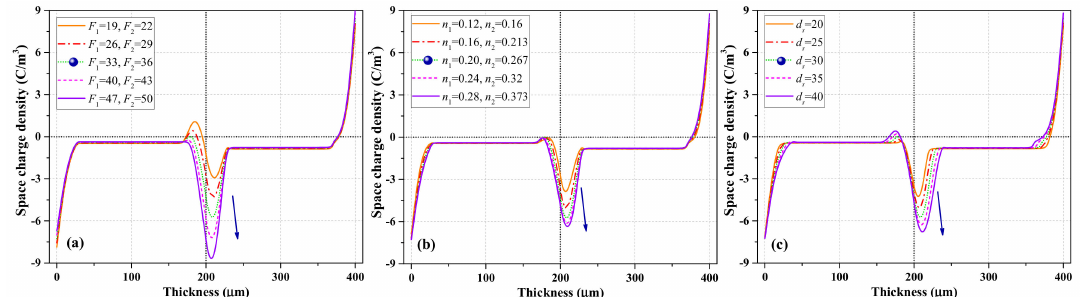
Figure 6. Simulation results of space charge after polarization for 1800 s of PET–PET samples. Influence of ( a ) F ( e ) for electrons, ( b ) n (e, h) , and ( c ) d s ( e , h )